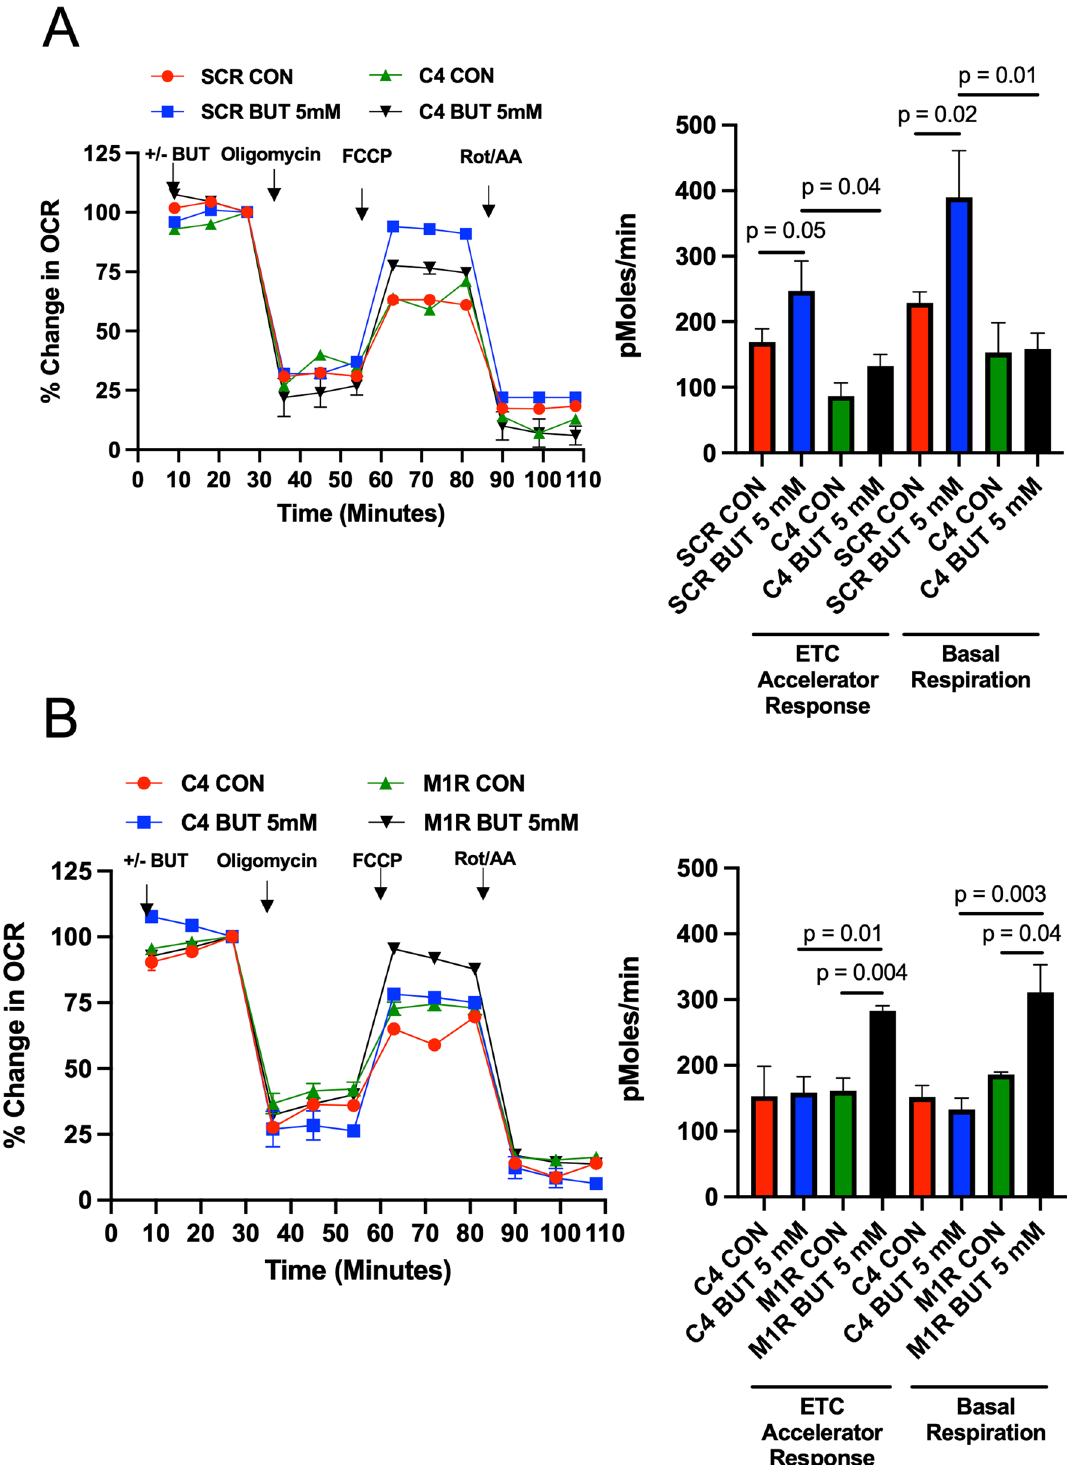
Figure 4. PKM1 is responsible for mitochondrial function in HCT116 colorectal cancer cells. ( A ) Percent change in oxygen consumption rate (OCR) relative to baseline in which SCR and C4 cells respond to oligomycin, FCCP, and Antimycin A/Rotenone. The right panel shows the calculated electron transport chain (ETC) accelerator response and basal respiration. ( B ) Percent change in OCR relative to baseline in which C4 and M1R cells respond to oligomycin, FCCP, and Antimycin A/Rotenone. The right panel shows the calculated ETC accelerator response and basal respiration. For these experiments, each cell line was treated with or without butyrate (5 mM). These measurements represent the mitochondrial function. Each data point represents the average OCR (%) over 3–5 replicates per condition. Error bars are mean ±